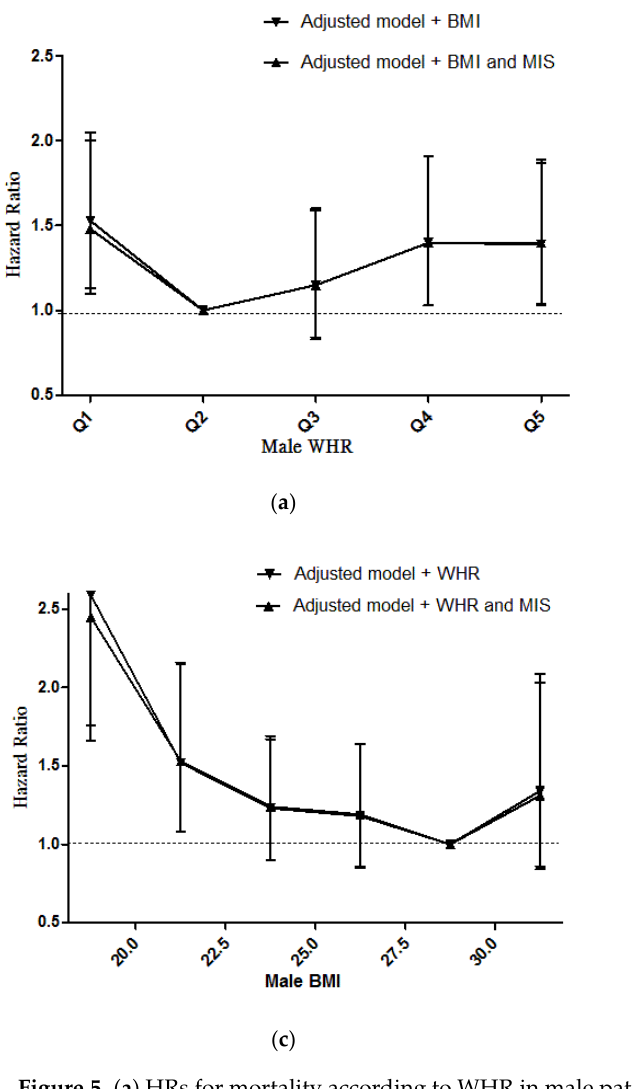
Figure 5. ( a ) HRs for mortality according to WHR in male patients before and after adjustment by BMI and MIS; ( b ) HRs for mortality according to WHR in female patients before and after adjustment by BMI and MIS; ( c ) HRs for mortality according to BMI in male patients before and after adjustment by WHR and MIS; ( d ) HRs for mortality according to BMI in female patients before and after adjustment by WHR and MIS. Adjusted model: adjusted for age, gender, eGFR, Upcr log, diabetes, cardiovascular disease, smoker, cancer, severe liver disease, hypertension, hemoglobin, cholesterol log, gly ‐ cosylated hemoglobin, albumin, CRP ln and phosphorus. Abbreviations: BMI: body mass index, WHR: waist ‐ to ‐ hip ratio, MIS: Malnutrition ‐ Inflammation Score.